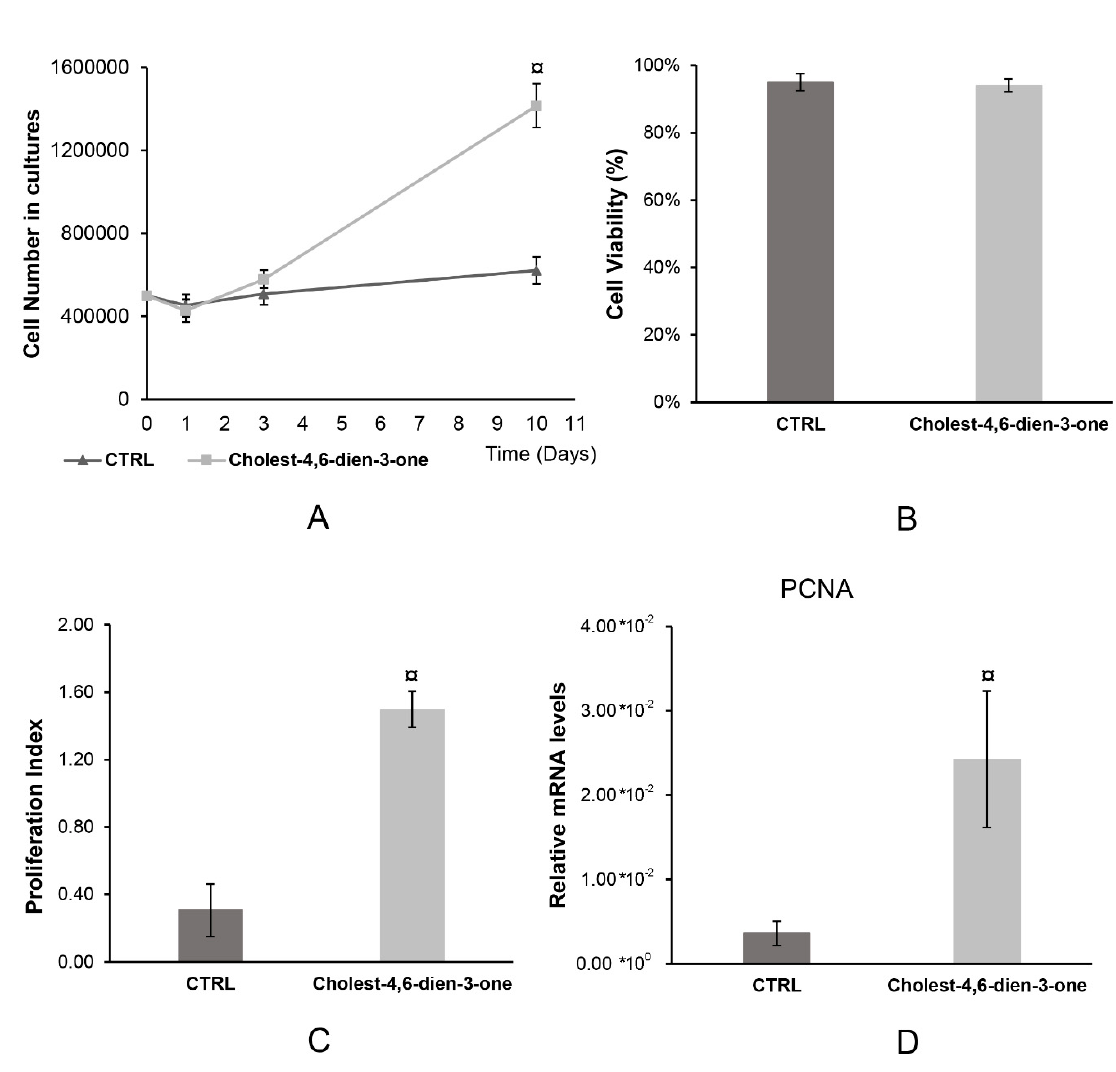
Figure 1. Cholest-4,6-dien-3-one enhance hBTSCs proliferation without a ff ecting cell viability. ( A ) Cell number in cultures determined by trypan blue exclusion assay of hBTSCs cultured in KM added with cholest-4,6-dien-3-one or basal condition (KM). ( B ) Cell viability measured by math equation described above of hBTSCs cultured in KM added with cholest-4,6-dien-3-one or basal condition (KM). ( C ) Proliferation index (PD) calculated by math equation described above of hBTSCs cultured in KM added with cholest-4,6-dien-3-one or basal condition (KM). ( D ) Relative PCNA mRNA level expression analyzed by RT-qPCR of hBTSCs cultured in KM added with cholest-4,6-dien-3-one or basal condition (KM). Data expressed as mean ± SD of N = 6 experiments; ¤ p < 0.0001.